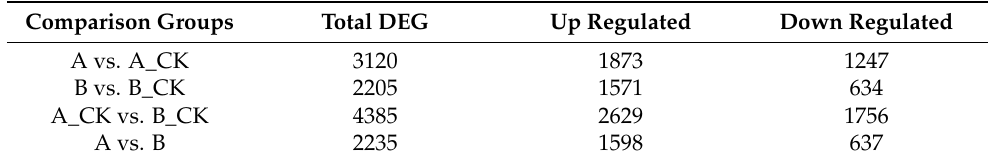
Table 1. Differentially expressed genes identified in four comparison groups of inoculated and un- inoculated disease resistant Dawei (A) and susceptible Qiuxiang (B) hazelnut varieties. Treatments: A-CK (Dawei-un-inoculated control), A (Dawei- inoculated with B. cinerea ), B-CK (Qiuxiang-un- inoculated control), B (Qiuxiang- inoculated with B. cinerea ). Comparison Groups Total DEG Up Regulated Down